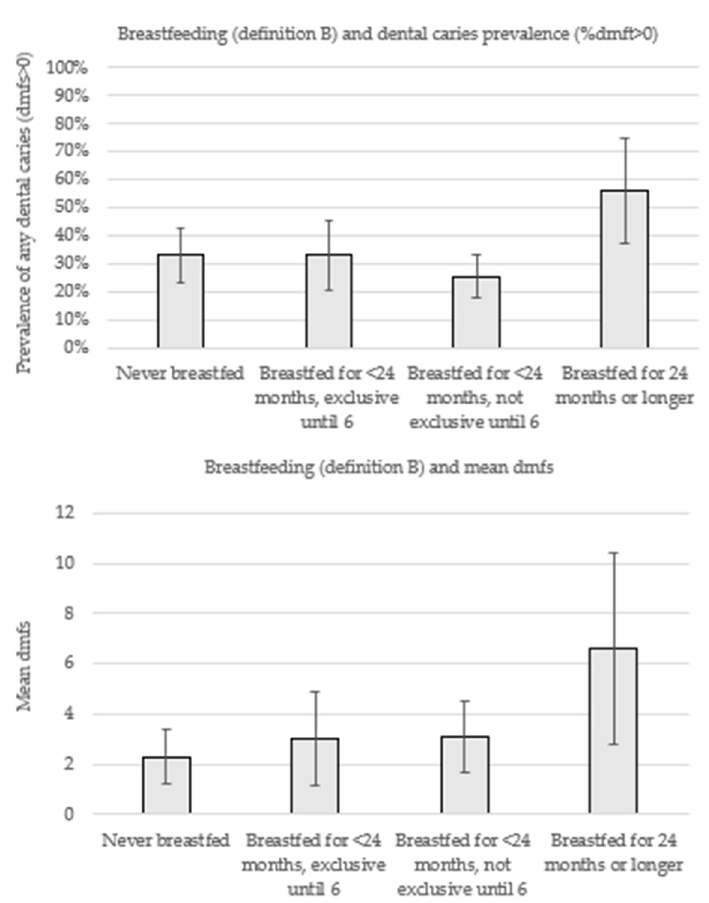
Figure 2. Prevalence of early childhood caries (ECC) and mean number of decayed, missing, and filled teeth (mean dmfs) according to breastfeeding patterns (definition B).